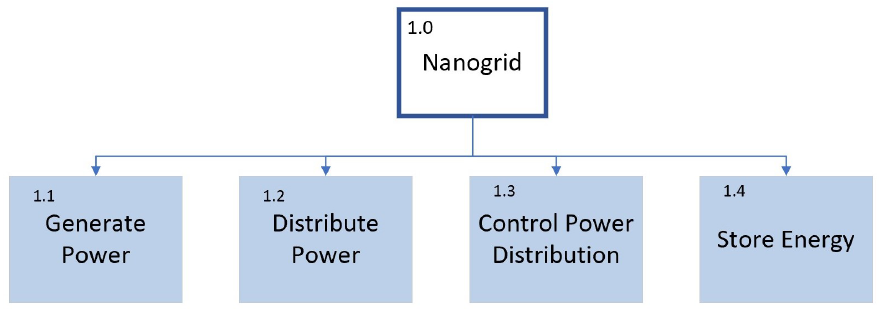
Figure 3. Microgrid and Nanogrid Functional Decomposition [2]. The functional decomposition represents the high-level functions that the system must perform to meet system